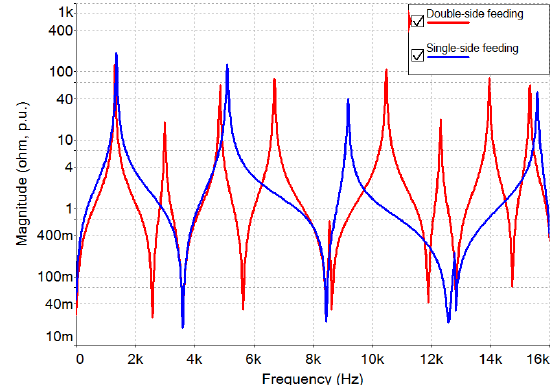
Figure 7. Equivalent impedance at the pantograph terminals in single- and double-feeding supply schemes.